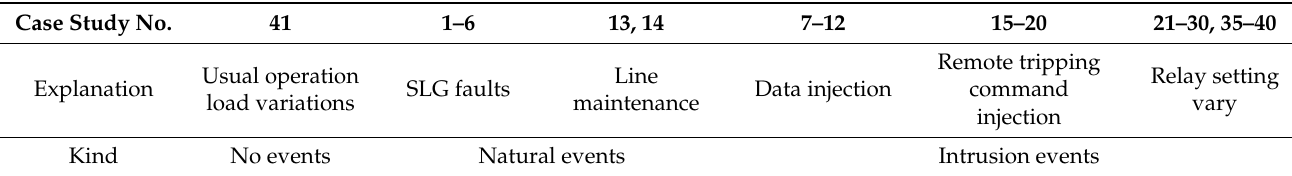
Table 1. Explanation of